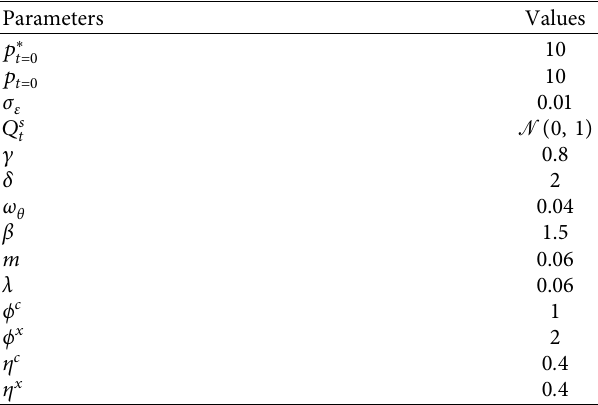
Table 10: Parameters of the agent-based model. Note: This table reports the parameters used in this paper. These parameters are chosen in accordance with Zhu et al. [35] and Amilon